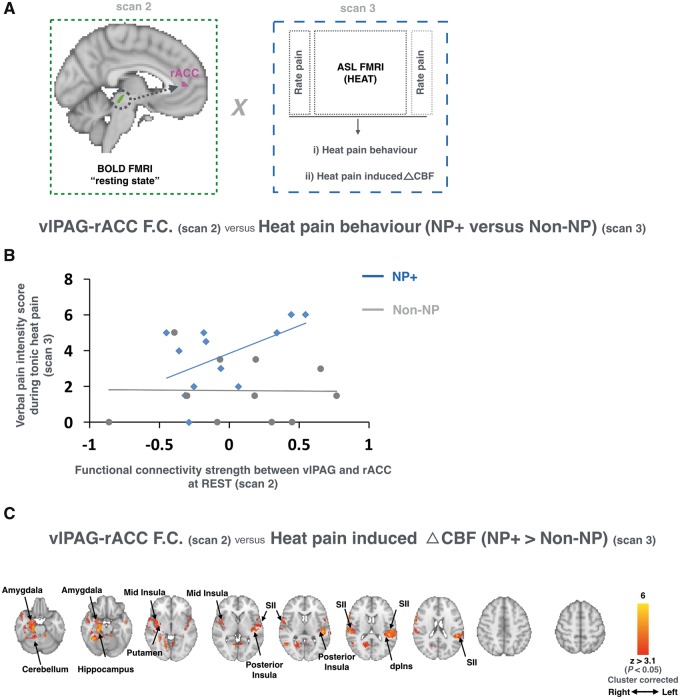

vlPAG functional connectivity predicts heat hyperalgesia. (A) A schematic of the analysis workflow used to test the relationship between the functional connectivity (F.C.) strength of the vlPAG-rACC (acquired in Scan 2) and the patients’ behavioural (B) and brain (C) responses to evoked tonic heat applied to their feet (acquired in Scan 3). (B) A linear correlation between resting vlPAG-rACC functional connectivity strength (from Scan 2) and the intensity of the pain reported during evoked tonic heat applied to the participants’ feet (from Scan 3; NP+: blue; non-NP: grey). (C) Tonic-heat induced hyper-perfusion (CBF; acquired in Scan 3) as a function of resting vlPAG-rACC functional connectivity (acquired during Scan 2). Regions within which the correlation between tonic heat induced changes in CBF and vlPAG-rACC connectivity strength were greater in NP+ versus non-NP patients are shown in red (n = 26, mixed effects, z > 3.1, P < 0.05 cluster corrected). The axial slices show the extent of activation across the whole brain. Radiological convention is used. FMRI = functional MRI.